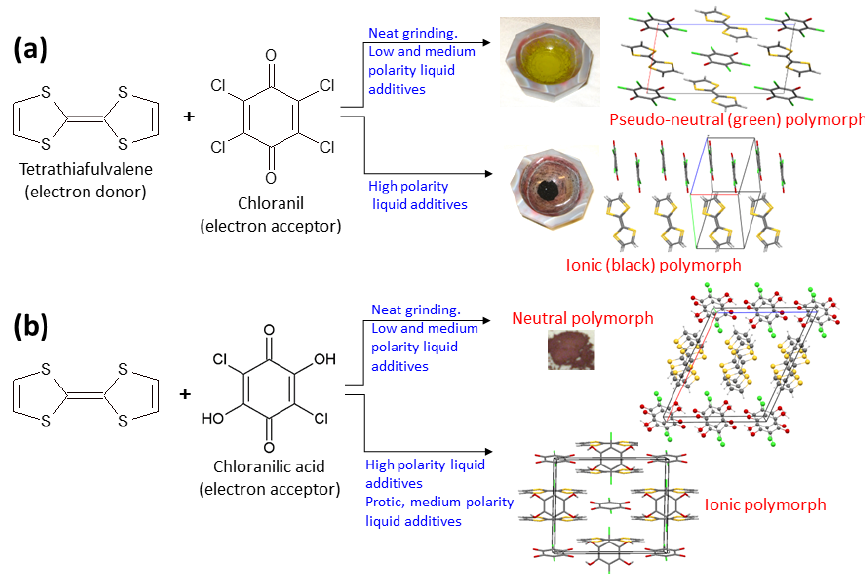
Figure 3. Liquid additive effects in the mechanochemical syntheses of charge transfer complexes of tetrathiafulvalene, showing different charge transferred (ionicities). For ( a ) the mechanochemical reaction of tetrathiafulvalene and chloranil [102], and ( b ) tetrathiafulvalene and chloranilic acid [83], the use of highly polar liquid additives, such as water and DMSO, above threshold quantities (often forming pastes ground in mortars) led to the respective ionic polymorphs, while neat grinding and pastes of low polarity liquids yielded neutral or pseudo-neutral forms, as indicated in the figure. The colors of the powders obtained as products, and a representation of their crystal packings followed by the names of each polymorphic form (in red) are also shown (C: gray, S: yellow, O: red, H: light gray). The dielectric constant of the liquids used as additives, and additionally their protic character in the reaction shown in ( b ), are deemed to have roles in the chemical mechanisms leading to particular polymorphs and ionicities. Note also that the neutral form of TTF-CAH 2 has been only obtained using mechanochemistry [83].